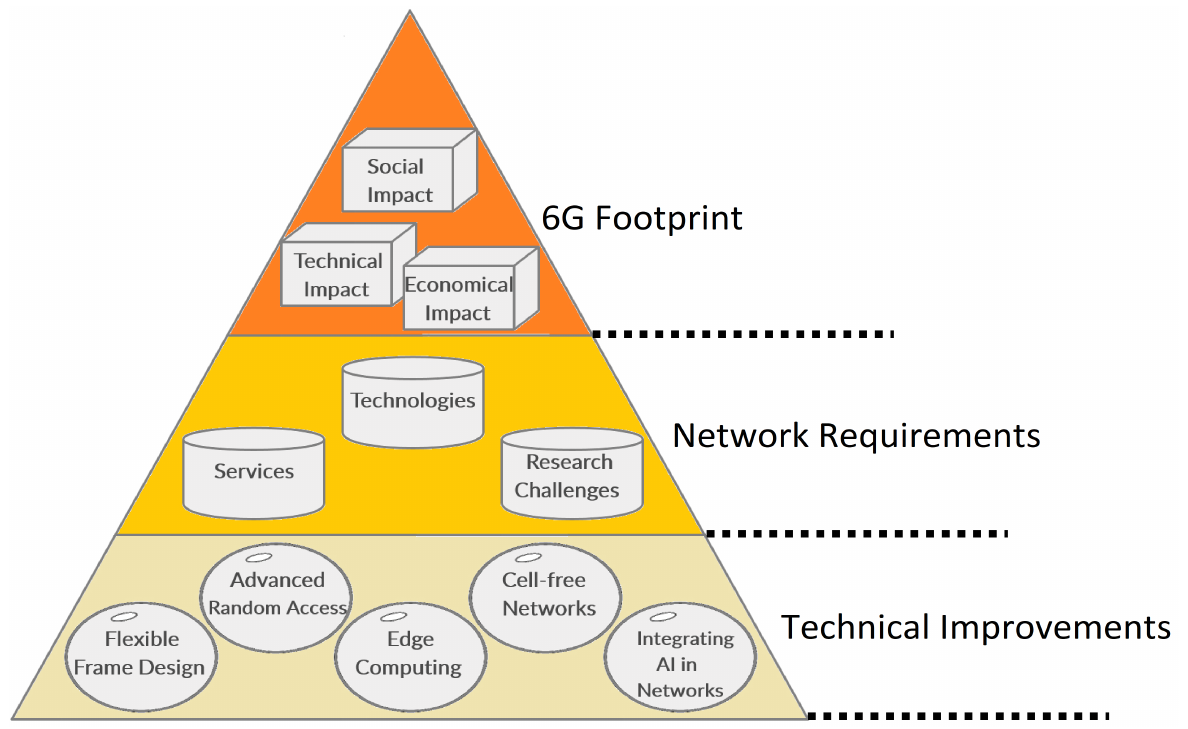
Figure 4. A hierarchical approach for the discussion of 6G’s